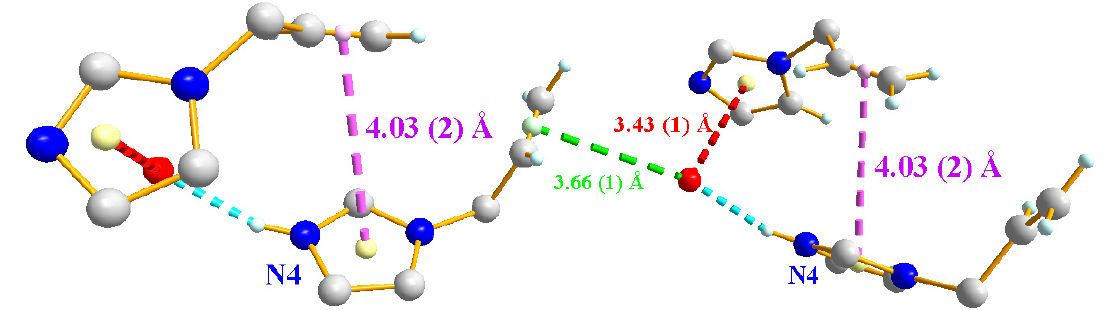
2(H 2 Figure 4. The π – π interactions between organic cations and water molecules in Bi 4 I 16 ·4(C 6 H 9 N 2 ) 2(H 2 O).